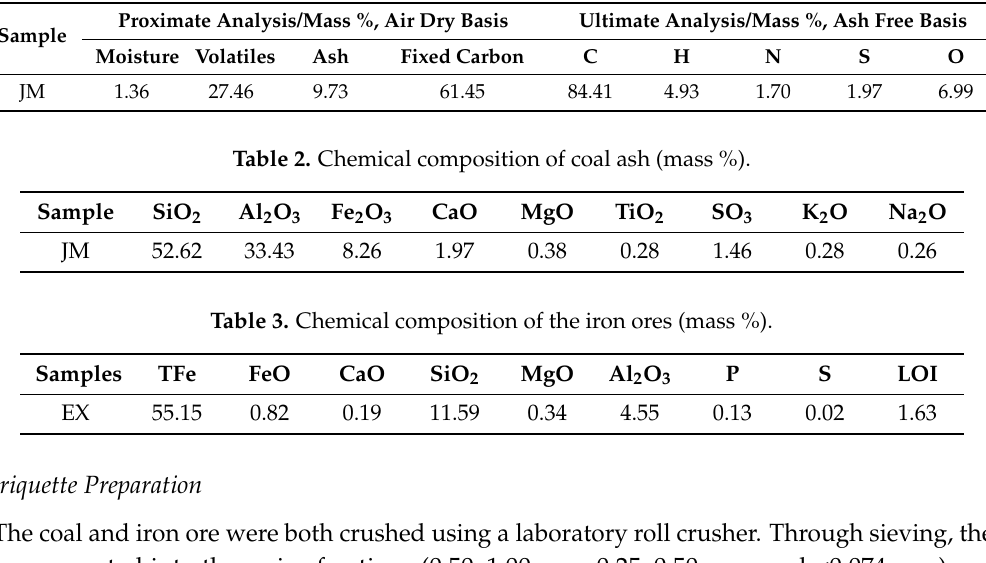
Table 1. Characterization data of the coal used in the experiments.